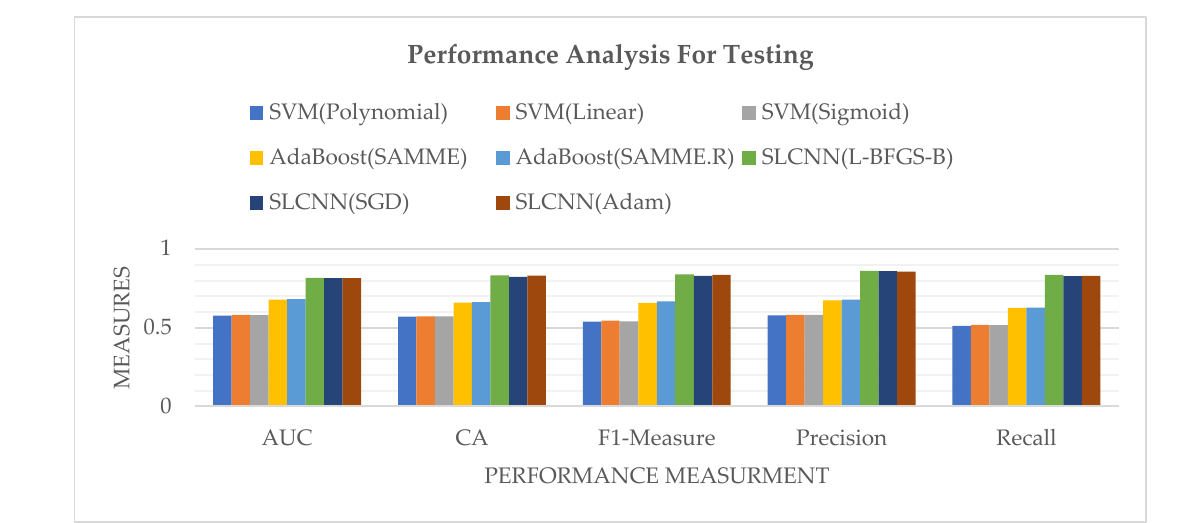
Figure 11. Model Comparison by Performance Measures during Testing.